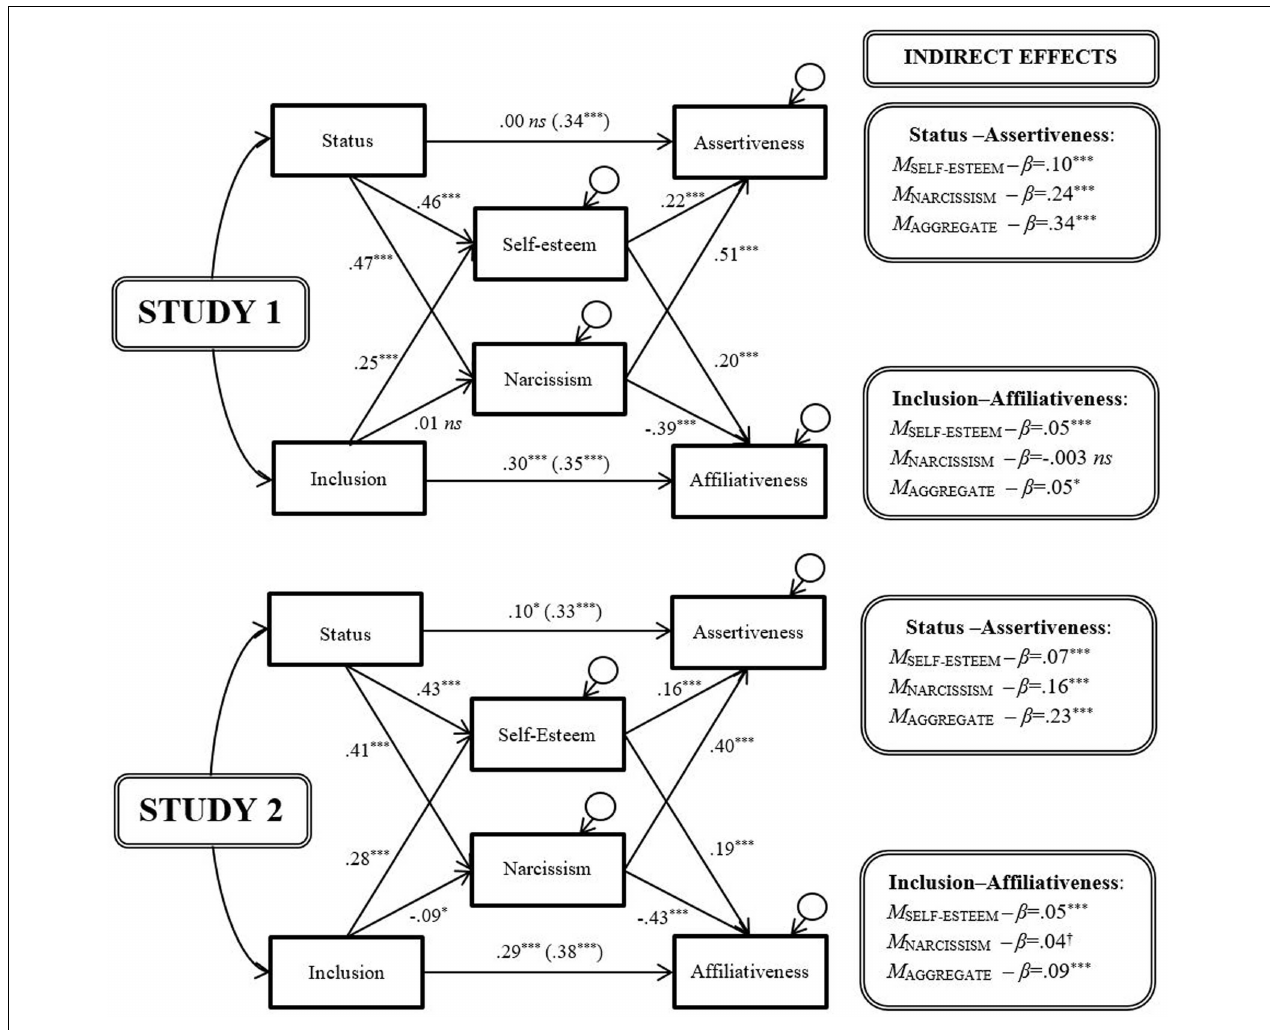
FIGURE 3 | The mediating effects of self-esteem and narcissism. † p < 0.10; ∗ p < 0.05; ∗∗ p < 0.01; ∗∗∗ p <